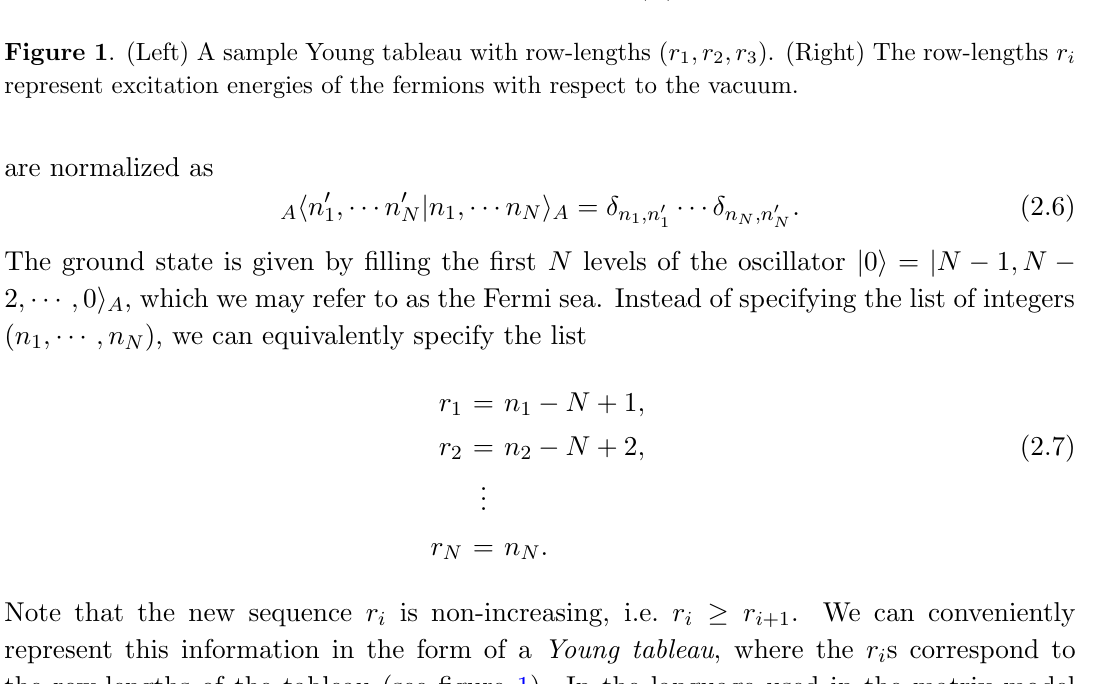
1 ; r 2 ; r 3 ). (Right) The row-lengths r i